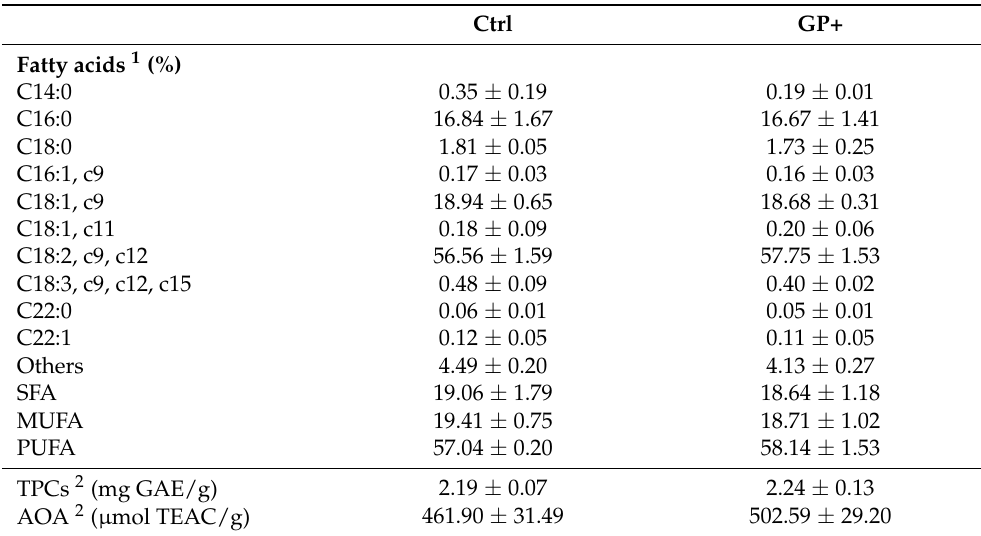
Table 2. Fatty acid profile, total phenolic content and antioxidant activity of the diet administered to the control group (Ctrl) and experimental group